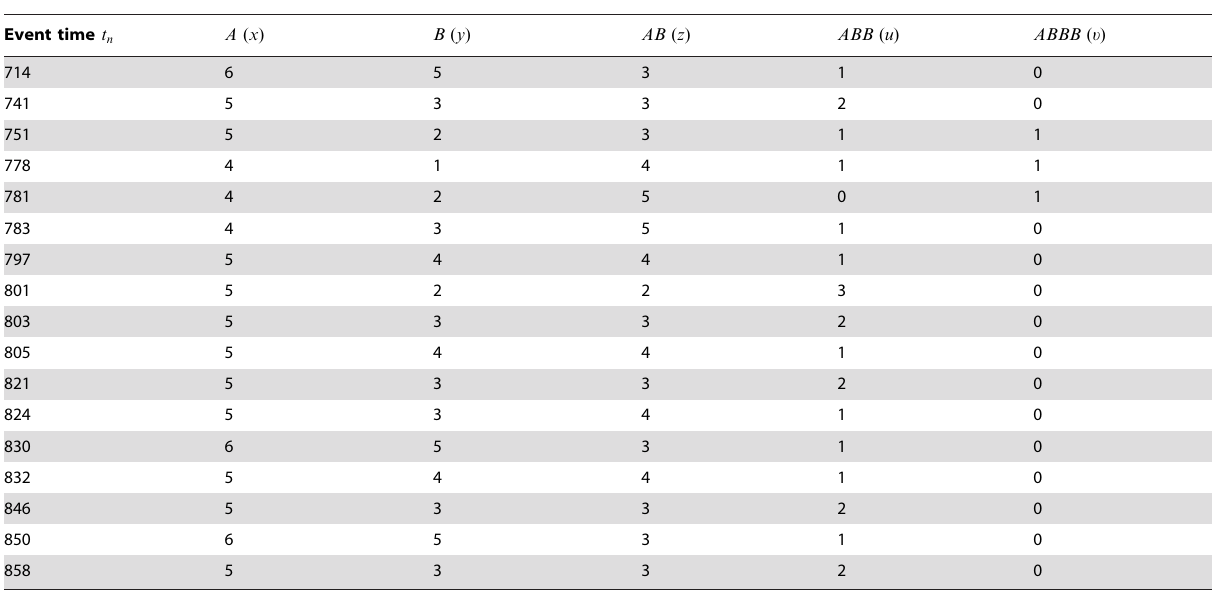
Table 1. An example of experimental data.